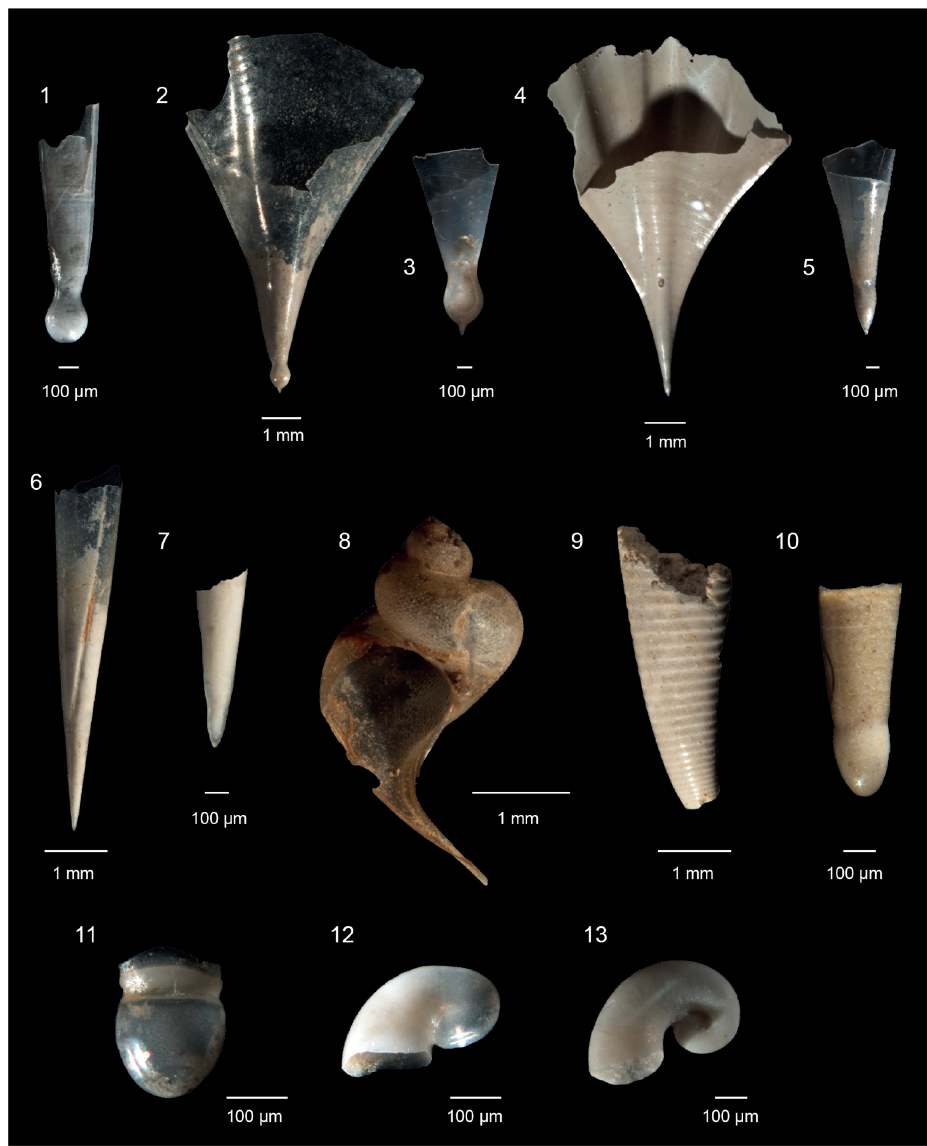
Figure 3. Pteropoda from the Levantine Basin (offshore of Israel). (1) Diacria trispinosa (de Blainville, 1821) protoconch; (2)–(3) Clio cuspidata (Bosc, 1801), (2) adult specimen, (3) protoconch; (4)–(5) Clio pyramidata (Linnaeus, 1767), (4) adult specimen, (5) protoconch; (6)–(7) Styliola subula (Quoy and Gaimard, 1827), (6) adult specimen, (7) protoconch; (8) Peracle reticulata (d’Orbigny, 1835); (9) Hyalo- cylis striata (Rang, 1828); (10) Clionidarum sp. 2; (11) Clionidarum sp. 1; (12) Gleba cordata (Niebuhr, 1776); (13) Pterotrachea